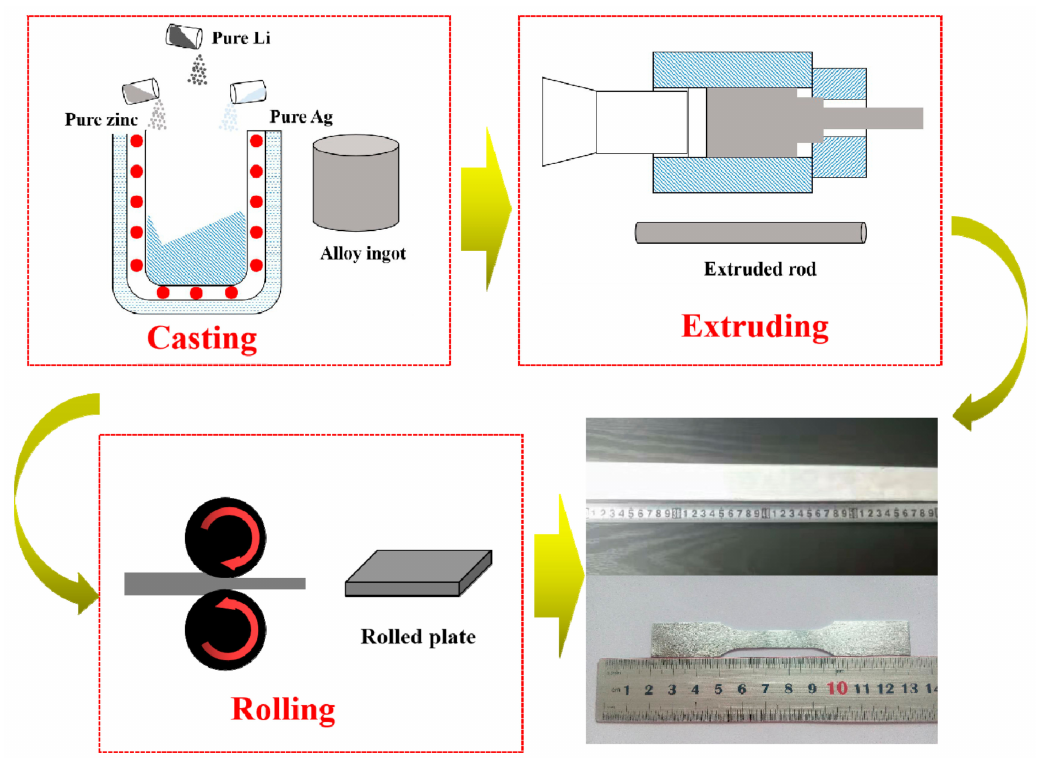
Figure 1. Schematic diagram of the fabrication process of the Zn-0.5%Li-0.1%Ag alloy. Different specimens of the Zn-0.5%Li-0.1%Ag alloy were used to investigate the